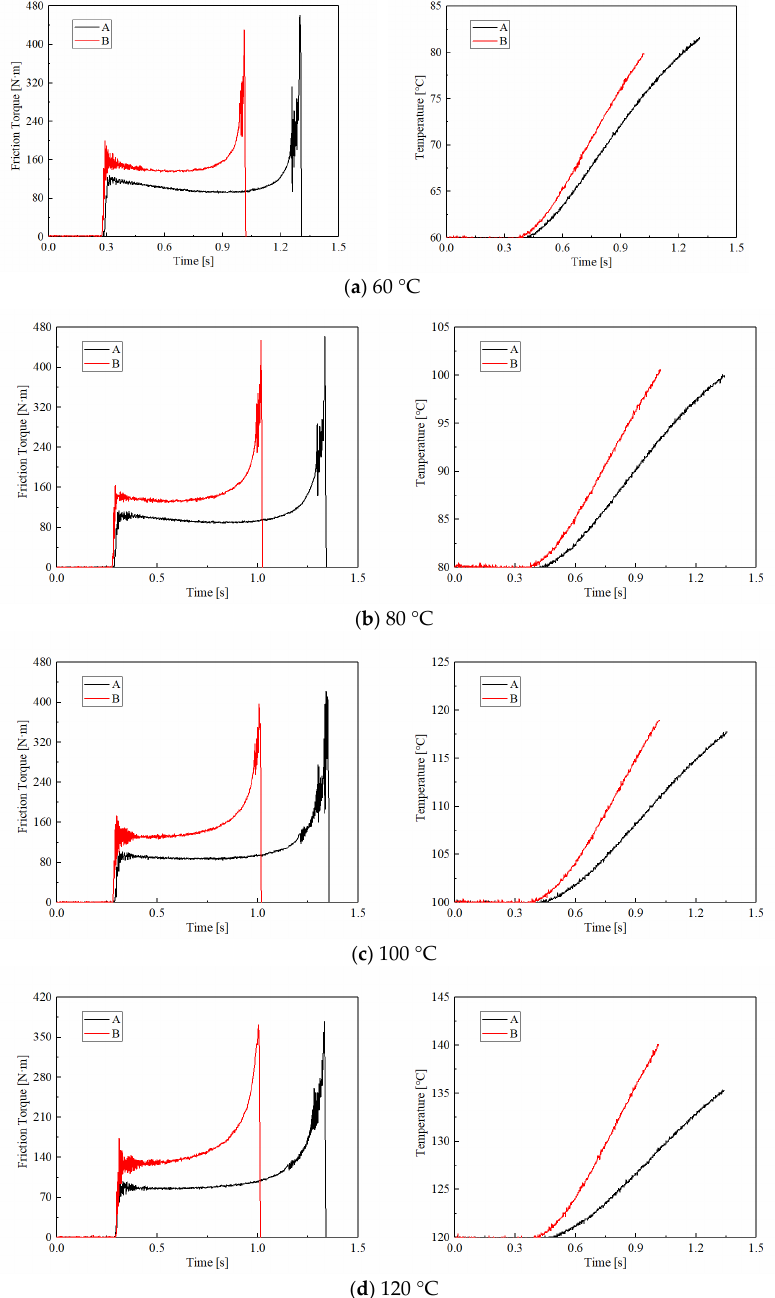
Figure 6. Variations of the friction torque and surface temperatures of CBFM-A and CBFM-B. ( a ) 60 °C, ( b ) 80 °C, ( c ) 100 °C, ( d ) 120 °C.